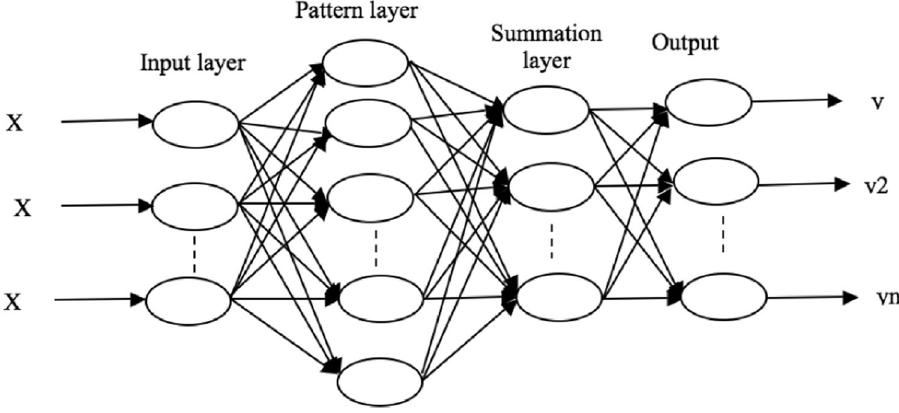
probabilistic neural networks (PNNs) (Mao et al.